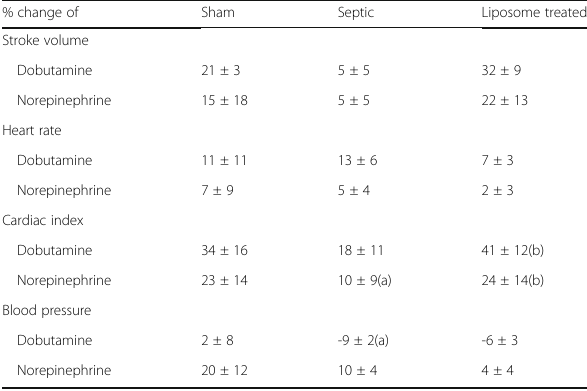
Table 1 (abstract 001187). See text for description % change